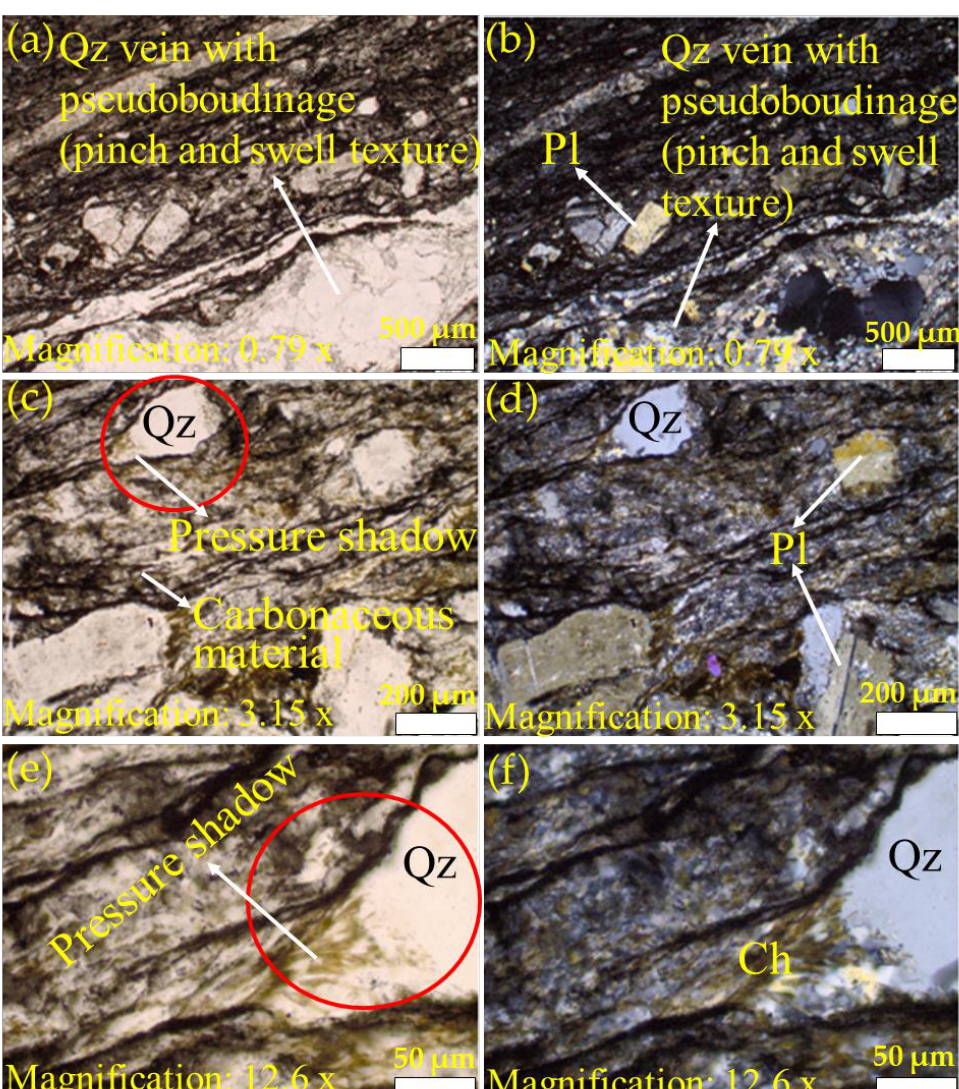
Figure 5. Petrographic analysis of the studied samples at 600 °C (Qz, Pl, and Ch represent quartz, plagioclase, and chlorite, respectively). Images ( a , c , e ) were taken using plane-polarized light while ( b , d , f ) were captured using cross-polarized light. Images ( a – f ) were taken at different magnifications to reveal rock texture, mineral composition, and alterations in meta-reworked crystal-rich felsic tuff. Images ( a , b ) illustrate an excellent example of boudinage where quartz-carbonate veins parallel to shear openings display distinct pinch and swell texture of boudinage. Additionally, note suboriented blastophyres of plagioclase and quartz set in highly sheared and foliated rock matrix in the image ( a , b ), while images ( c , d ) display unequigranular blastoporphyritic texture. Note highly sheared and foliated felsic rock matrix carrying blastoporphyrites of plagioclase and quartzthat display rotation fabric and the presence of pressure shadows which are marked by granulation and the presence of tiny biotite (partially chloritized) flakes. Images ( e , f ) are higher magnification of the red circle area of the image ( c ) to reveal more distinctly pressure shadows. Note that tail-shaped quartz pressure shadows display granulation of quartz blastoporphyrite and the presence of tiny greenish biotite flakes.